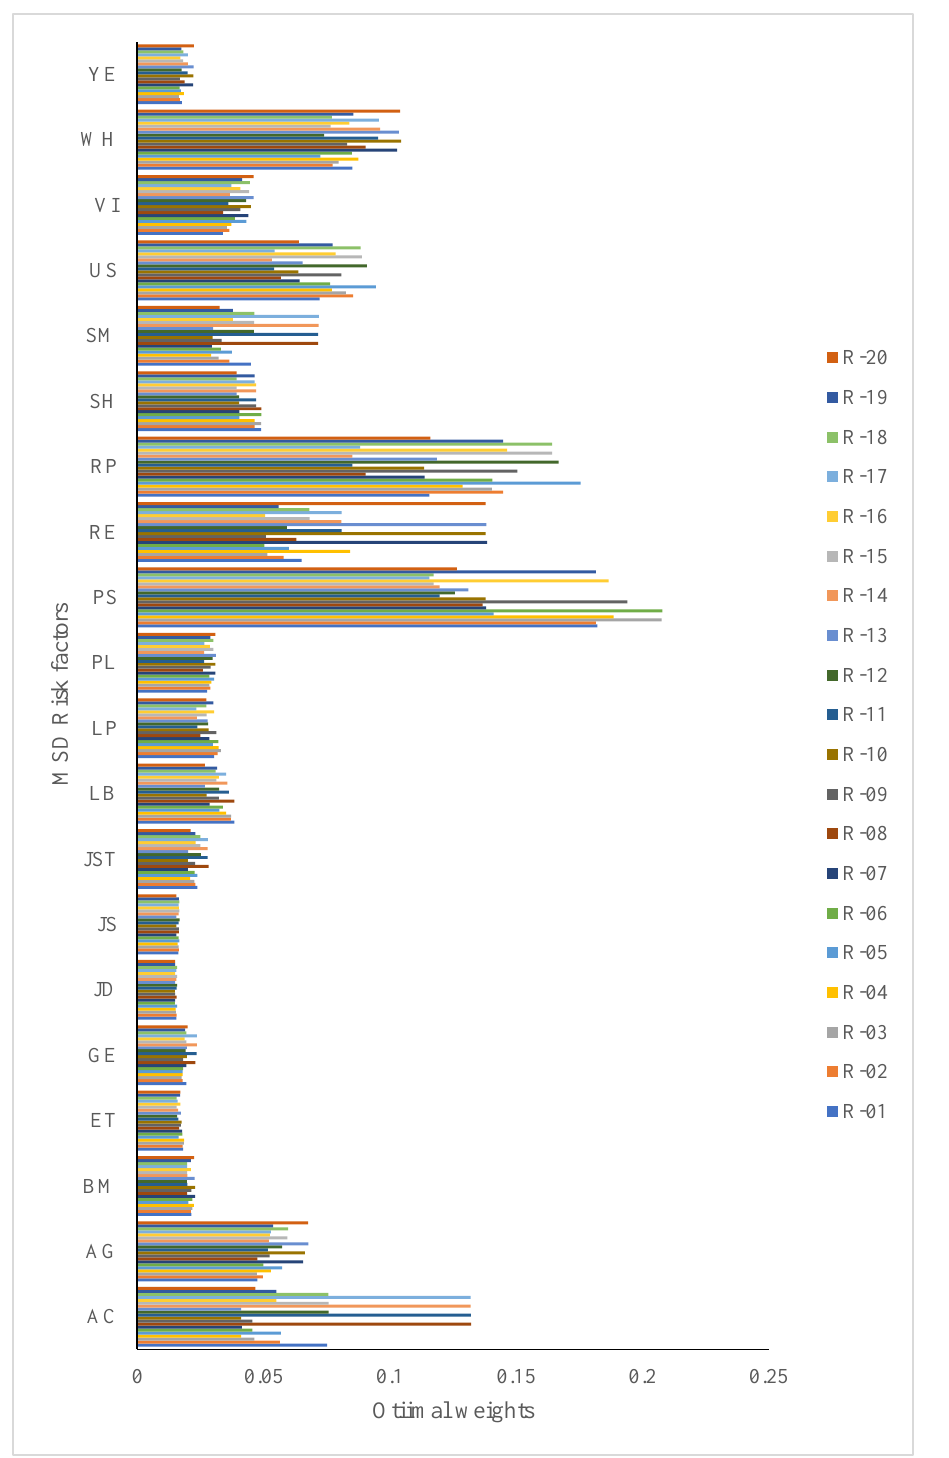
Figure 1. Variation in the optimal weight of risk factors during sensitivity analysis.